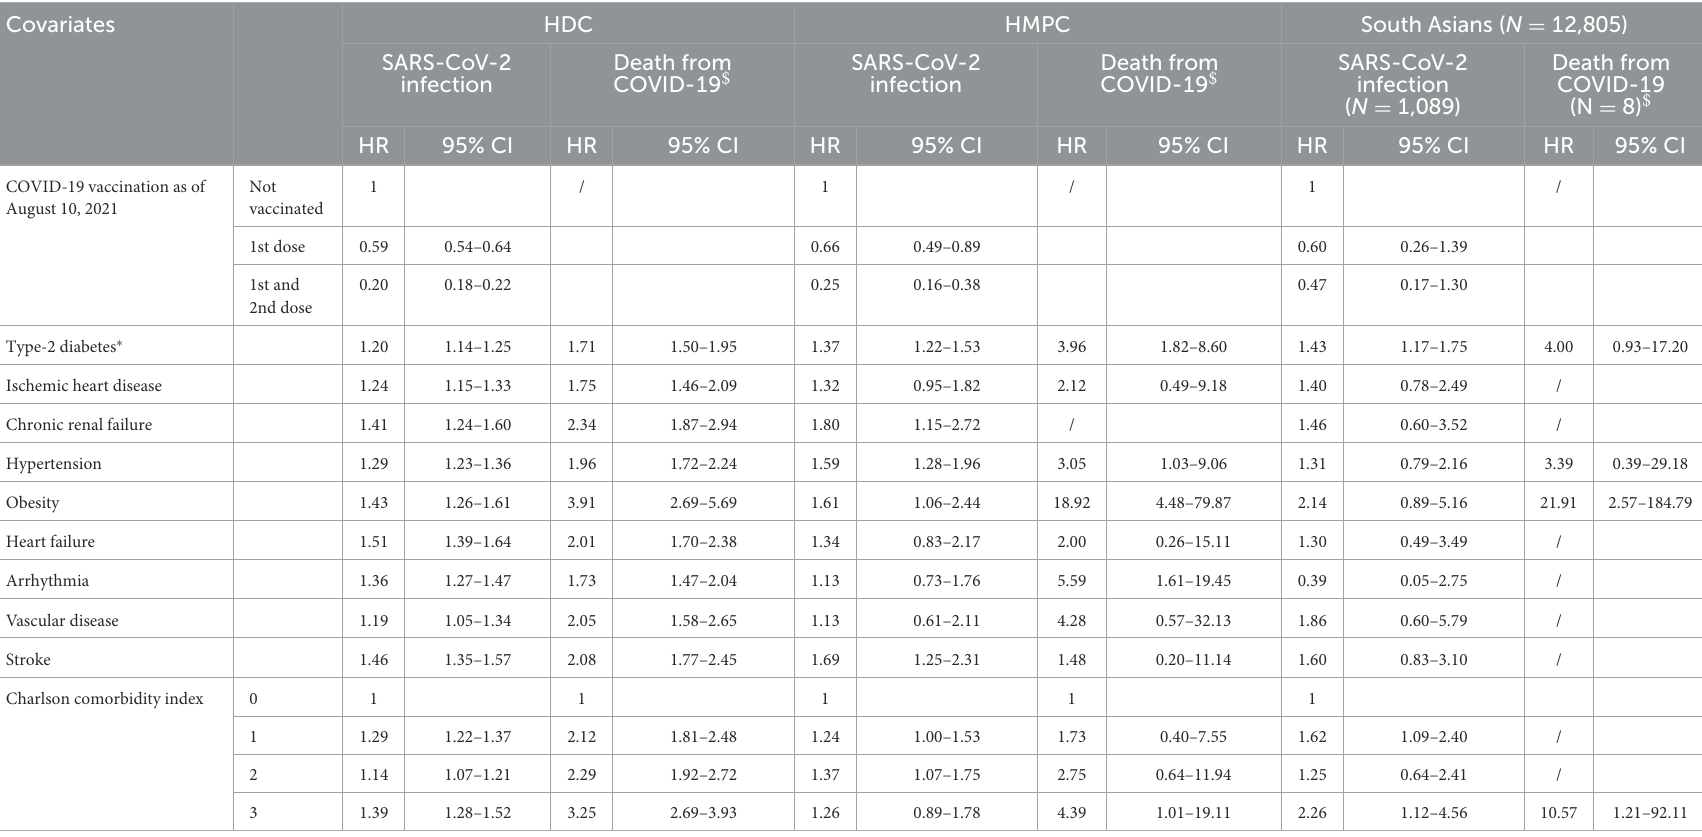
TABLE 2 Hazard ratios (HRs) of first infections from SARS-CoV-2 and deaths from COVID-19, by demographic and clinical characteristics, stratified by HDC, HMPC and South Asian populations.